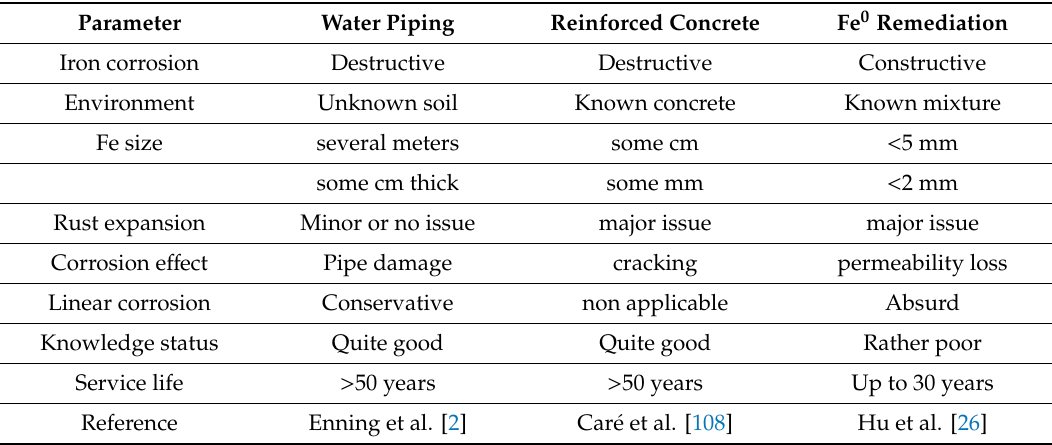
Table 2. Comparison of iron corrosion parameters in Fe 0 remediation to that of water pipes and reinforced